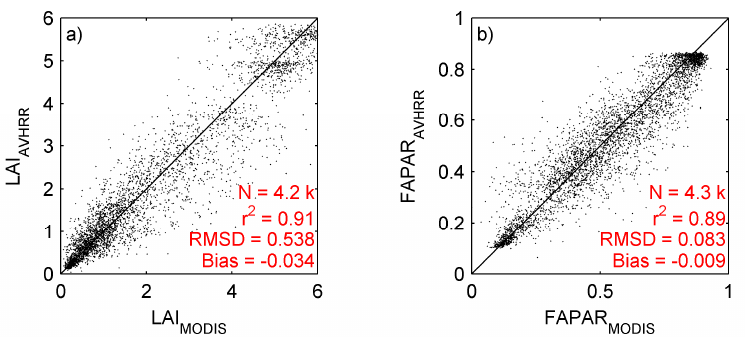
Figure 8. Comparison of MODIS and AVHRR LAI ( a ) and FAPAR ( b ) from 2001 to 2007. Data were extracted over DIRECT sites not used during the training process.